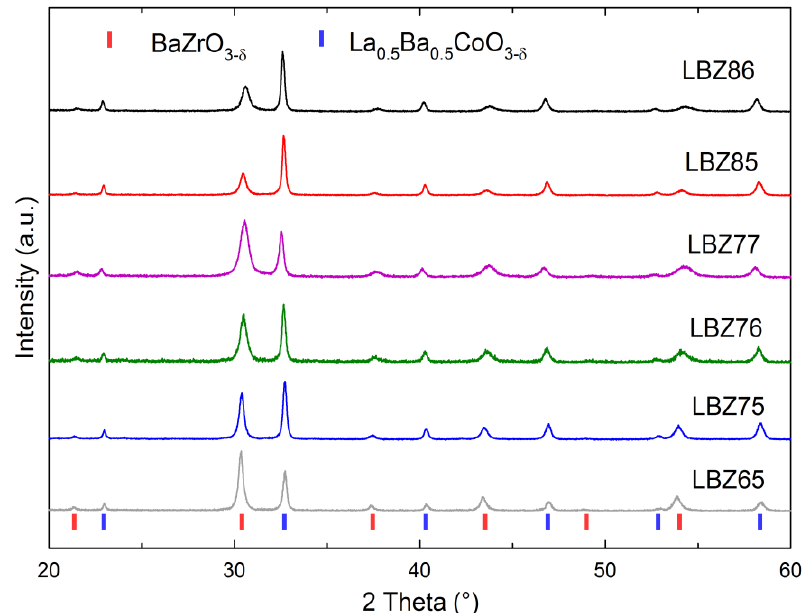
Figure 3. X-ray diffraction (XRD) patterns at room temperature of the composites with nominal composition La 1-x Ba x CoO 3- δ -BaZr 1-z-y Y z Co y O 3- δ ex situ exsolved at 1100 °C. Bragg reflections of BaZrO 3- δ (red) and La 0.5 Ba 0.5 CoO 3- δ (blue) are shown for comparison.